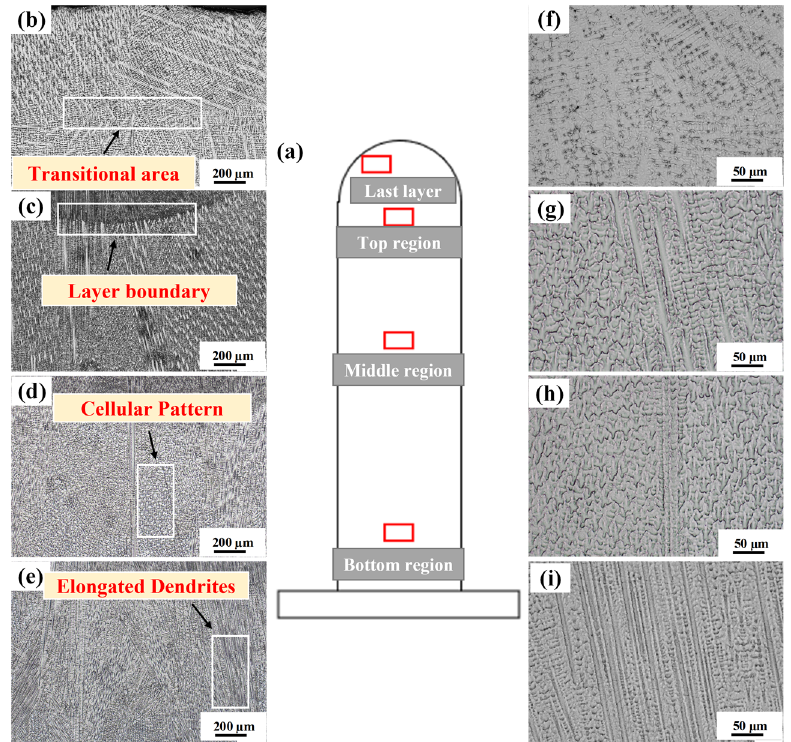
Figure 4. Microstructure morphology in cross-section (y–z plane) of the as-fabricated sample with heat input 552 J/mm. ( a ) Illustration of microstructure observing position. ( b – i ) Representative mi- crostructure at low and high magnifications for different positions: ( b , f ) last layer, ( c , g ) top region, ( d , h ) middle region and ( e , i ) bottom region.